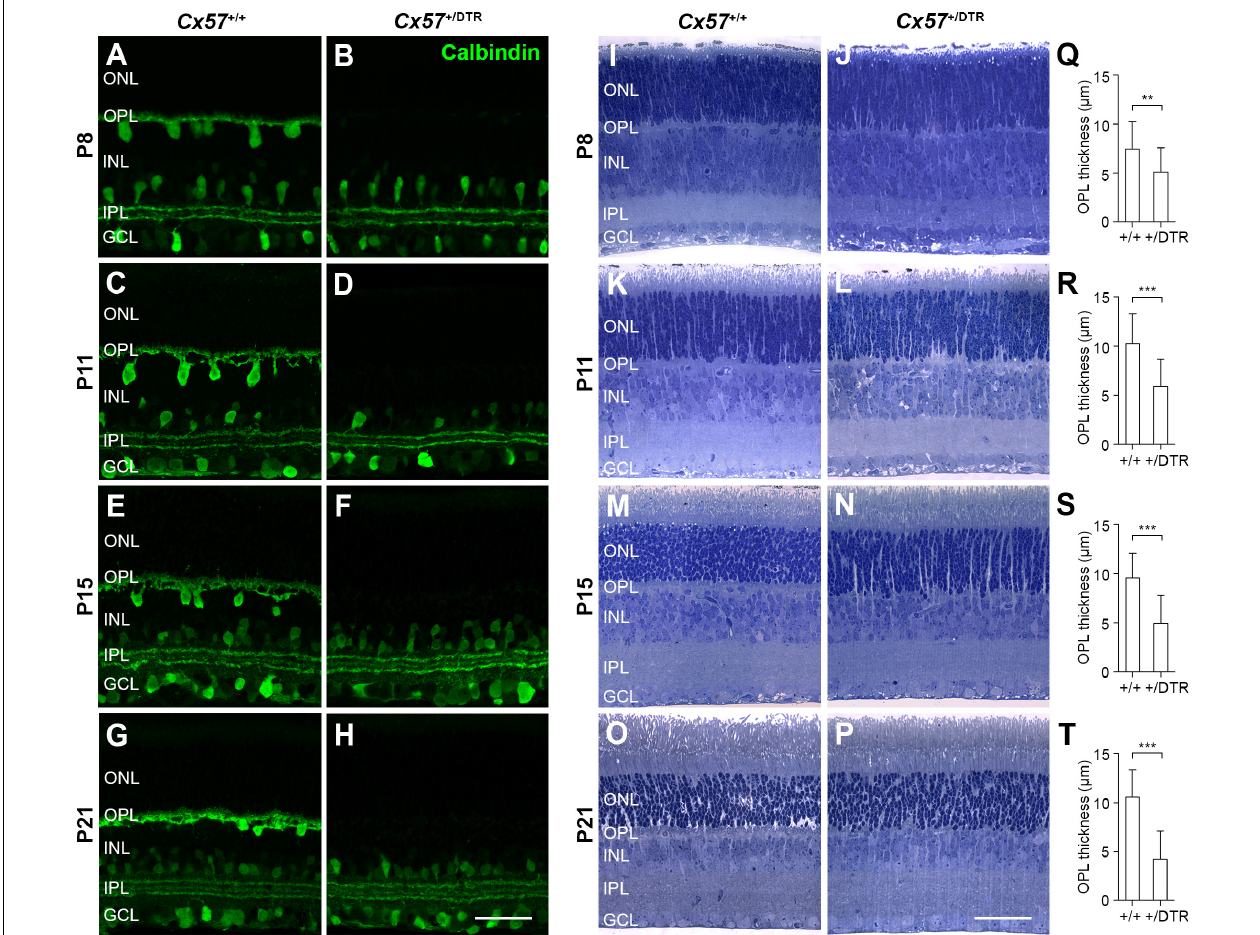
FIGURE 1 | Eliminating horizontal cells during early postnatal development results in defective formation of the OPL. (A–H) Retinal cryosections of DT-injected Cx57 + / + and Cx57 + / DTR mice were stained for calbindin, a horizontal cell marker. In Cx57 + / DTR retinae, calbindin labeling of horizontal cells was strongly reduced at P8 (B) and completely missing as early as P11 (D,F,H) . The gross morphology of calbindin-immunoreactive amacrine and ganglion cells was unaltered. (I–P) Toluidine blue staining of retinal semithin sections from Cx57 + / + and Cx57 + / DTR mice. The OPL of horizontal cell-ablated retinae was markedly thinner from P8 to P21 compared to wild-type retinae. The thickness of all other retinal layers was similar for both genotypes. (Q–T) Quantification of OPL thickness in Cx57 + / + ( n = 3 for P8, n = 4 for P11, n = 5 for P15, n = 3 for P21) and Cx57 + / DTR ( n = 3 for P8, n = 4 for P11, n = 3 for P15, n = 2 for P21) mice. p < 0.01 (P8), p < 0.0001 (P11, P15, P21), Wilcoxon rank sum test. Values are presented as mean ± SD. ∗∗ p < 0.01, ∗∗∗ p < 0.001. Scale bars, 50 µ m.